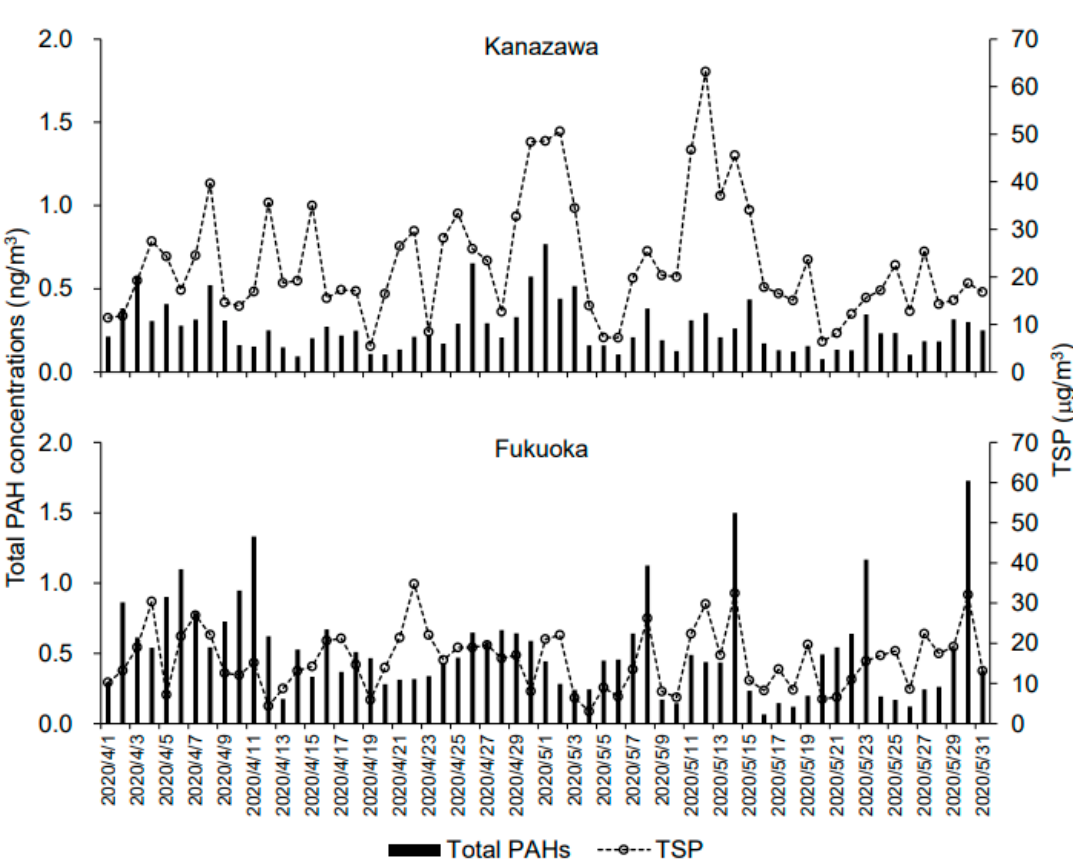
Figure 1. The course of the concentrations of total PAH and TSP in Kanazawa and Fukuoka during the study period. PAH, polycyclic aromatic hydrocarbons; TSP, total suspended particles. Table 3. Concentrations of PAHs and other air pollutants in Kanazawa and Fukuoka between